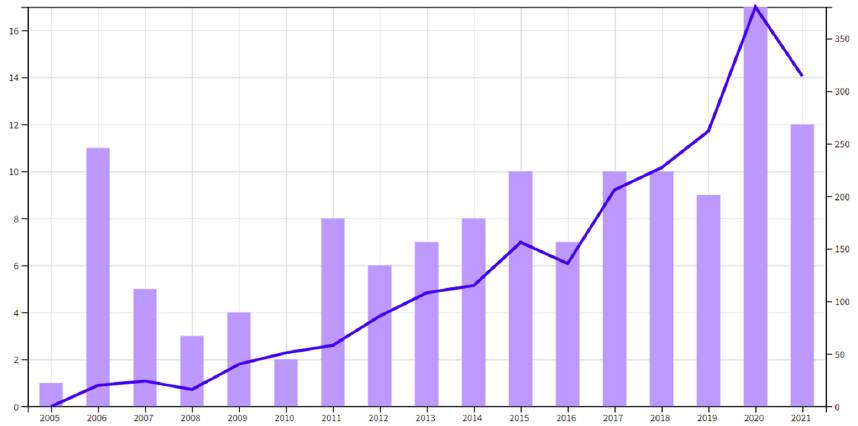
Figure 6. Papers published by year of publication according to the developed database. Publi- cation, citation.